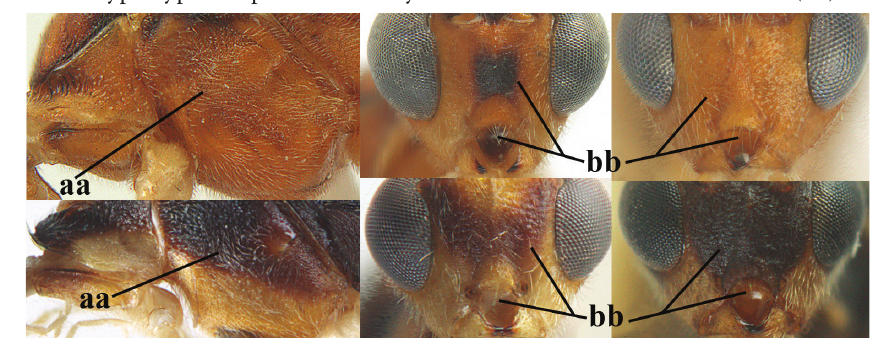
Mesopleuron largely rather matt and distinctly sculptured (aa; at least coria- ceous or granulate, though sometimes only weakly so); maximum width of